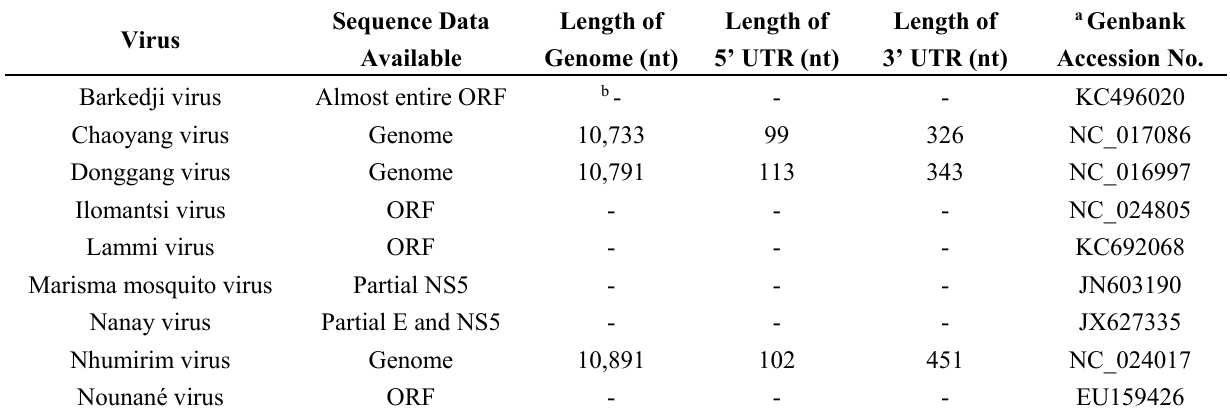
Table 5. Summary of sequence data available for dual–host affiliated insect-specific